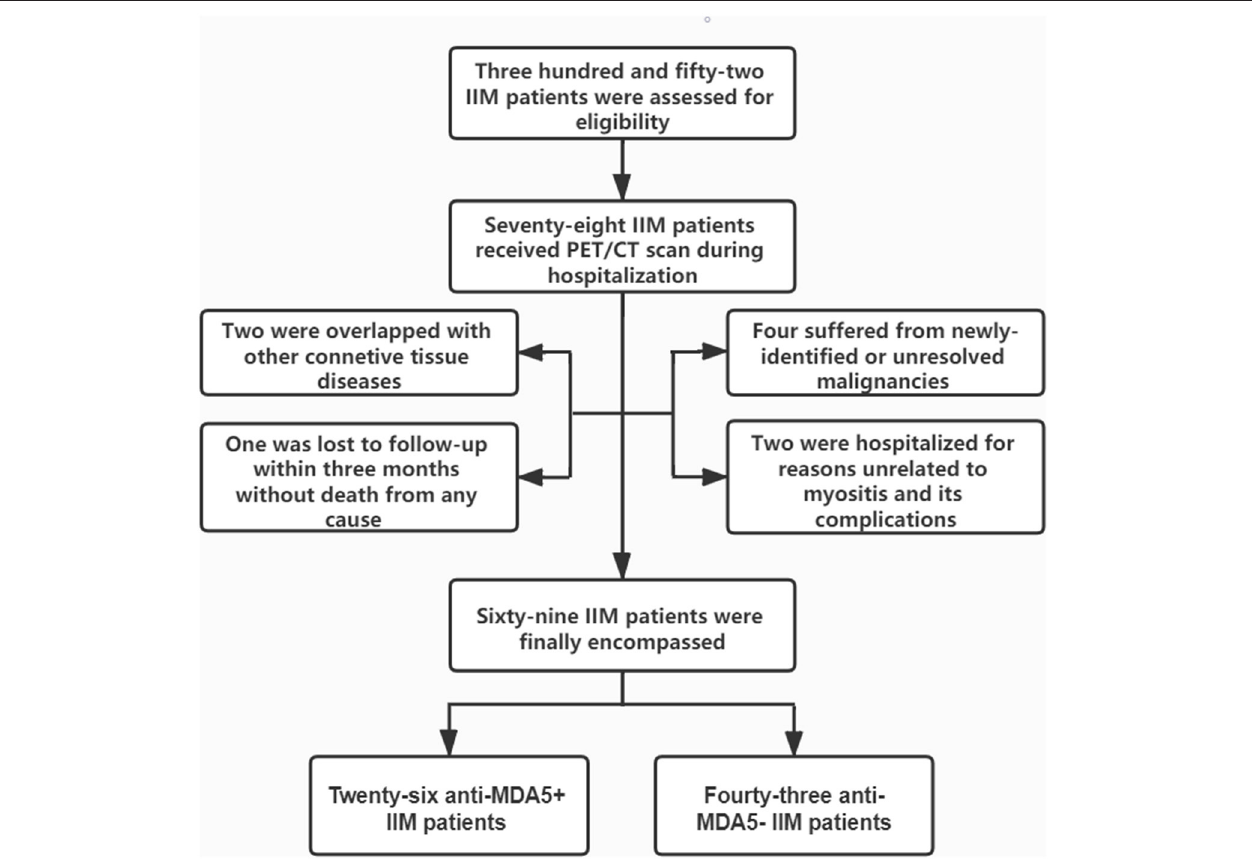
FIGURE 1 | Enrollment and groupings of this study. IIM, idiopathic inflammatory myopathies; PET/CT, positron emission tomography/computed tomography; MDA5, melanoma differentiation associated protein